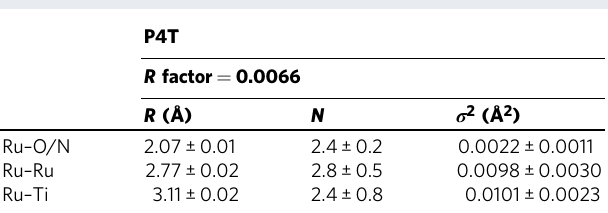
Fig. 1 Structural studies determining photocatalyst elemental compositions. a XRD analysis of Ti-MOF, P4T, P4T-D, P4T-A, P4T-D-A, TEM analysis of b P4T, c P4T-D, d HAADF of Ag in P4T-D, and contact angle studies of e P4T, and f P4T-D. Table 1 Ru K edge EXAFS Fitting